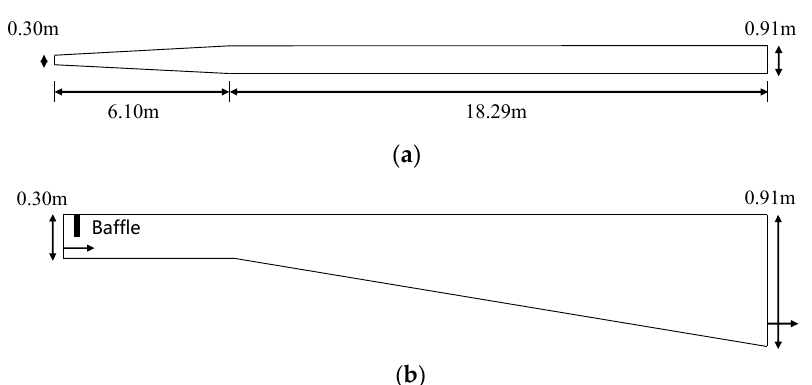
Figure 1. Sketch of the generalized reservoir hydrodynamics (GRH) flume. ( a ) Plan view. ( b ) Side view. Table 1. Settings of the σ -coordinate system model and the z-coordinate system model.